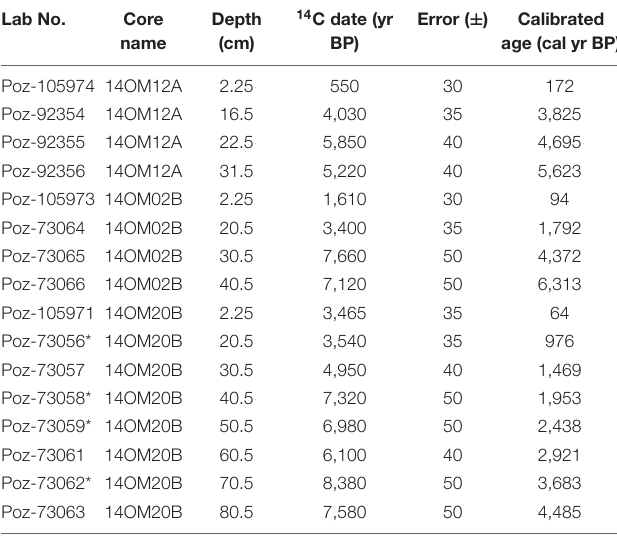
TABLE 2 | AMS radiocarbon dates from Omoloy cores 14OM12A (typical tundra), 14OM02B (forest tundra), and 14OM20B (open larch forest), northern Siberia. Lab